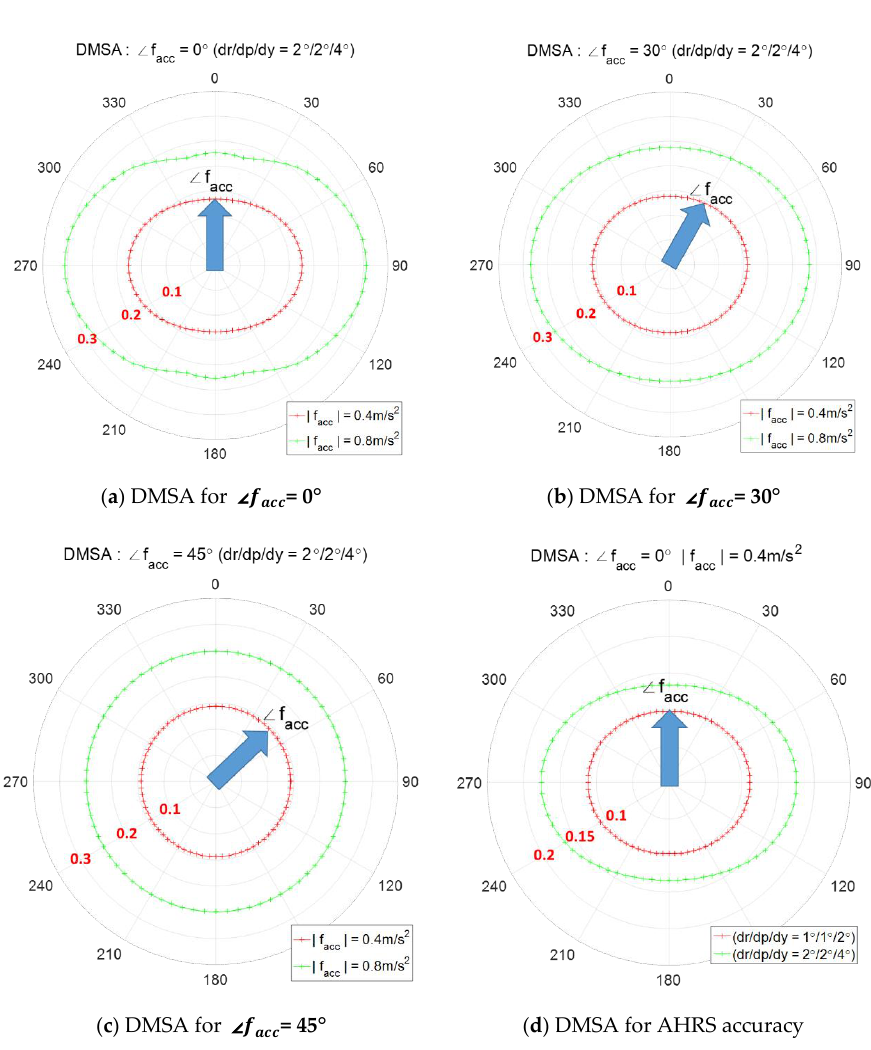
Figure 11. Contour of DMSA using the decision variable 𝒛 𝒎𝒂𝒈 , the angle denotes the direction of 𝒇 𝒔 , i.e., ∠ 𝒇 𝒔 ; ( a ) ∠ 𝒇 𝒂𝒄𝒄 = 0° , ( b ) ∠ 𝒇 𝒂𝒄𝒄 = 30° , ( c ) ∠ 𝒇 𝒂𝒄𝒄 = 45° , and ( d ) AHRS accuracy. ∠ f s ; ( a ) ∠ f acc = 0 ◦ , ( b ) ∠ f acc = 30 ◦ , ( c ) ∠ f acc = 45 ◦ , and ( d ) AHRS